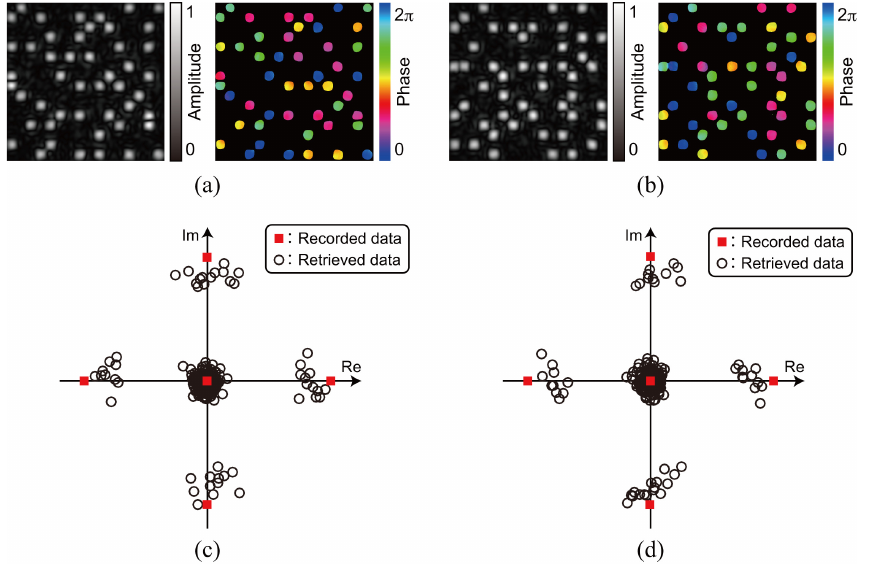
Figure 12. Experimental results of correlation-based multiplexing. Complex amplitude distribution of the retrieved ( a ) data page 1 and ( b ) data page 2. Averaged complex amplitude values of the retrieved ( c ) data page 1 and ( d ) data page 2 on a complex